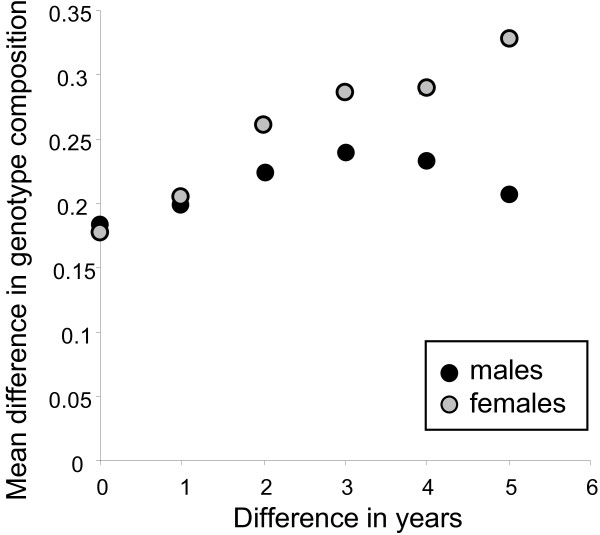
The effect of time on changes in genotype composition. Mean pairwise difference in genotype composition between catching rounds within ponds as a function of the difference in years between these catching rounds. The pairwise differences in genotype composition between catching rounds were measured as their distance in a ternary plot.